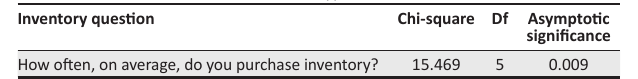
TABLE 9: Kruskal–Wallis test results on Hypothesis 1.